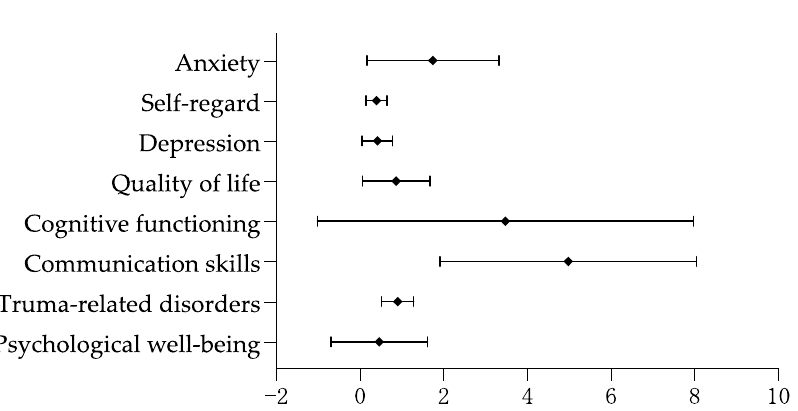
Figure 5. Overall effectiveness of drama-based intervention with pre/post-test groups.